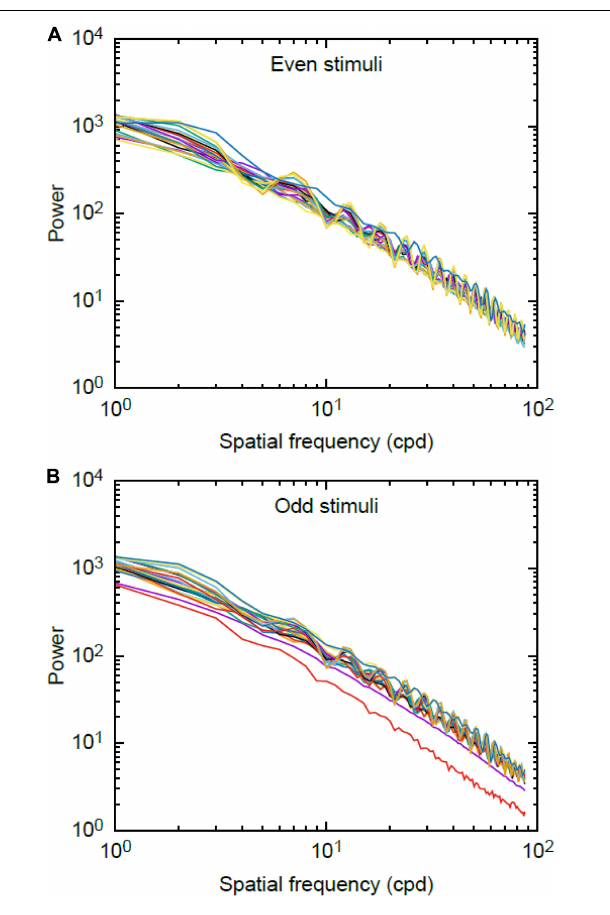
FIGURE 6 | Log-log plot of spatial frequency spectra for (A) even and (B) odd stimuli used during experiments. Data plotted are the 92 stimuli for the even set and the 88 stimuli for the odd set. There is no significant difference between mean value of the power spectra of the odd and even stimuli.